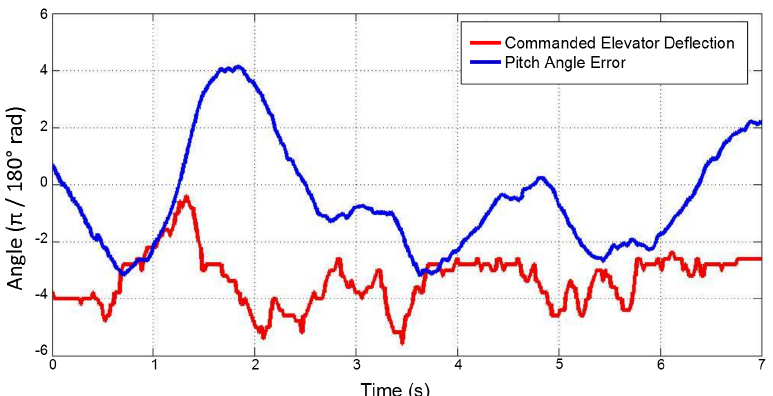
Figure 9. Typical values of pitch angle error and commanded elevator deflection during steady level flight.